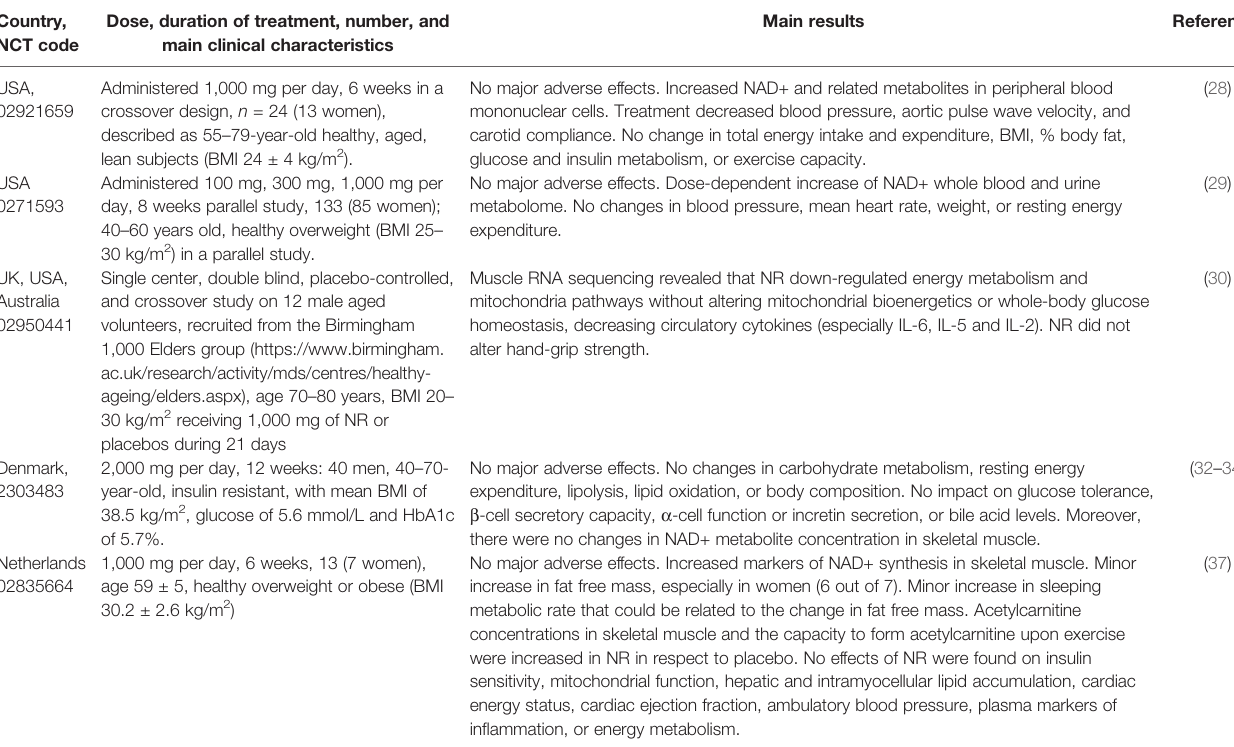
TABLE 2 | Recently (from 2018) published randomized, double-blind, placebo-controlled clinical trials that tested NR administration on individuals either healthy, aged, or overweight or obese. Country, Dose, duration of treatment, number, and NCT code main clinical